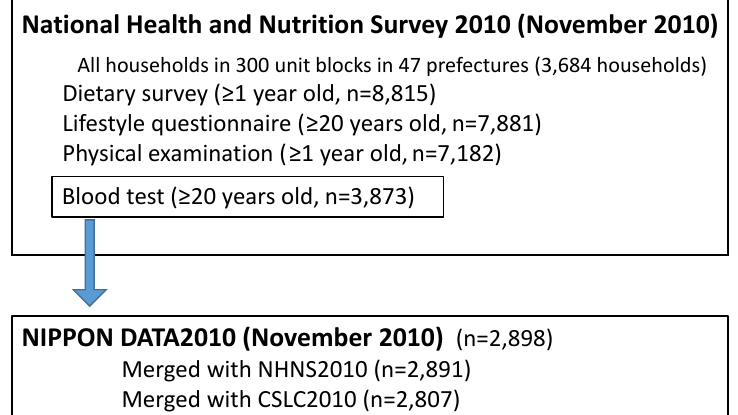
Figure 1. Study population of NIPPON DATA2010. The 5,510 CEAs selected for CSLC2010 were divided into 11,000 unit blocks consisting of 20 – 30 households each for NHNS2010 sampling. CEA, census enumeration area; CSLC2010, Comprehensive Survey of Living Conditions 2010; NHNS2010, National Health and Nutrition Survey